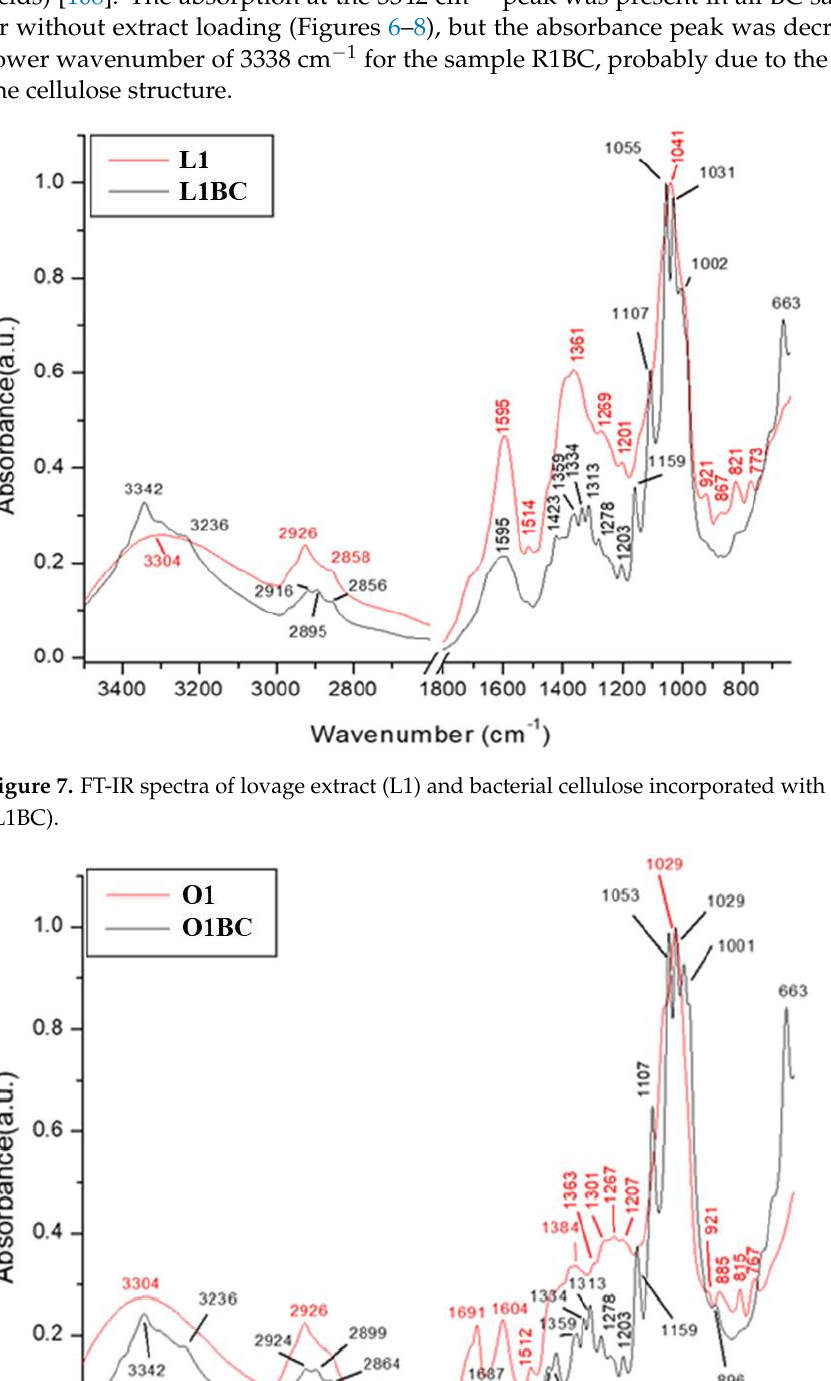
Figure 6. FT-IR spectra of bacterial cellulose (BC) and bacterial cellulose incorporated with rosemary